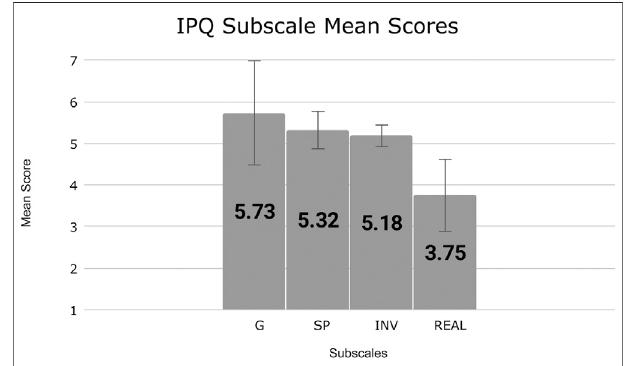
FIGURE 11 | Bar chart showing IPQ subscales on the horizontal axis and respective mean scores on the vertical axis, including standard deviations.